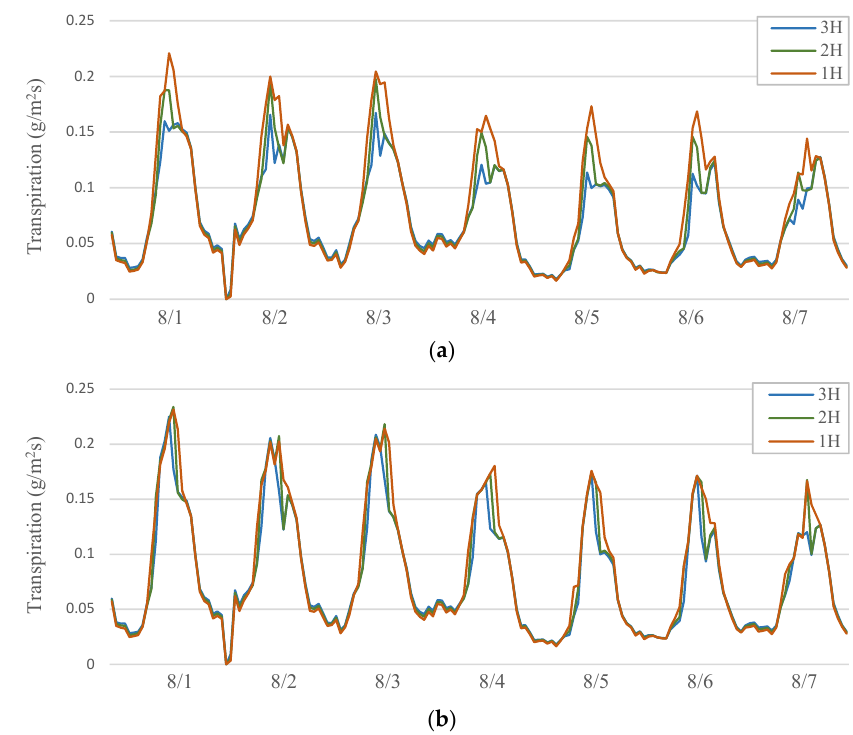
Figure 8. Change of transpiration rate with building height (1H, 2H, 3H). ( a ) South tree, ( b ) north tree. (LAD distribution: C.D).